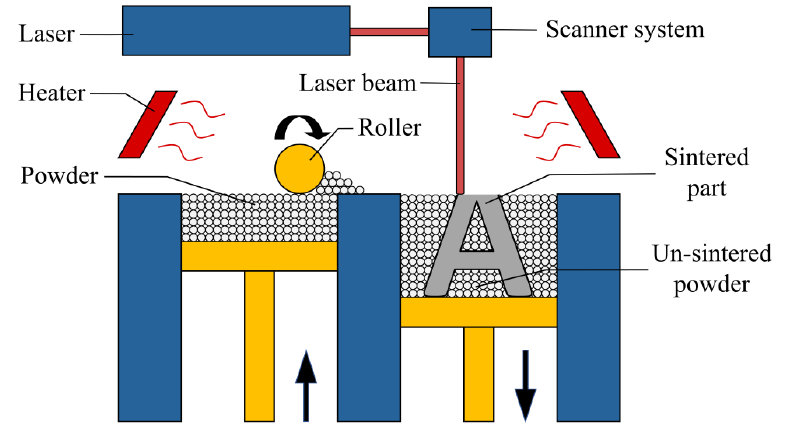
Figure 1. Schematic of selective laser sintering.